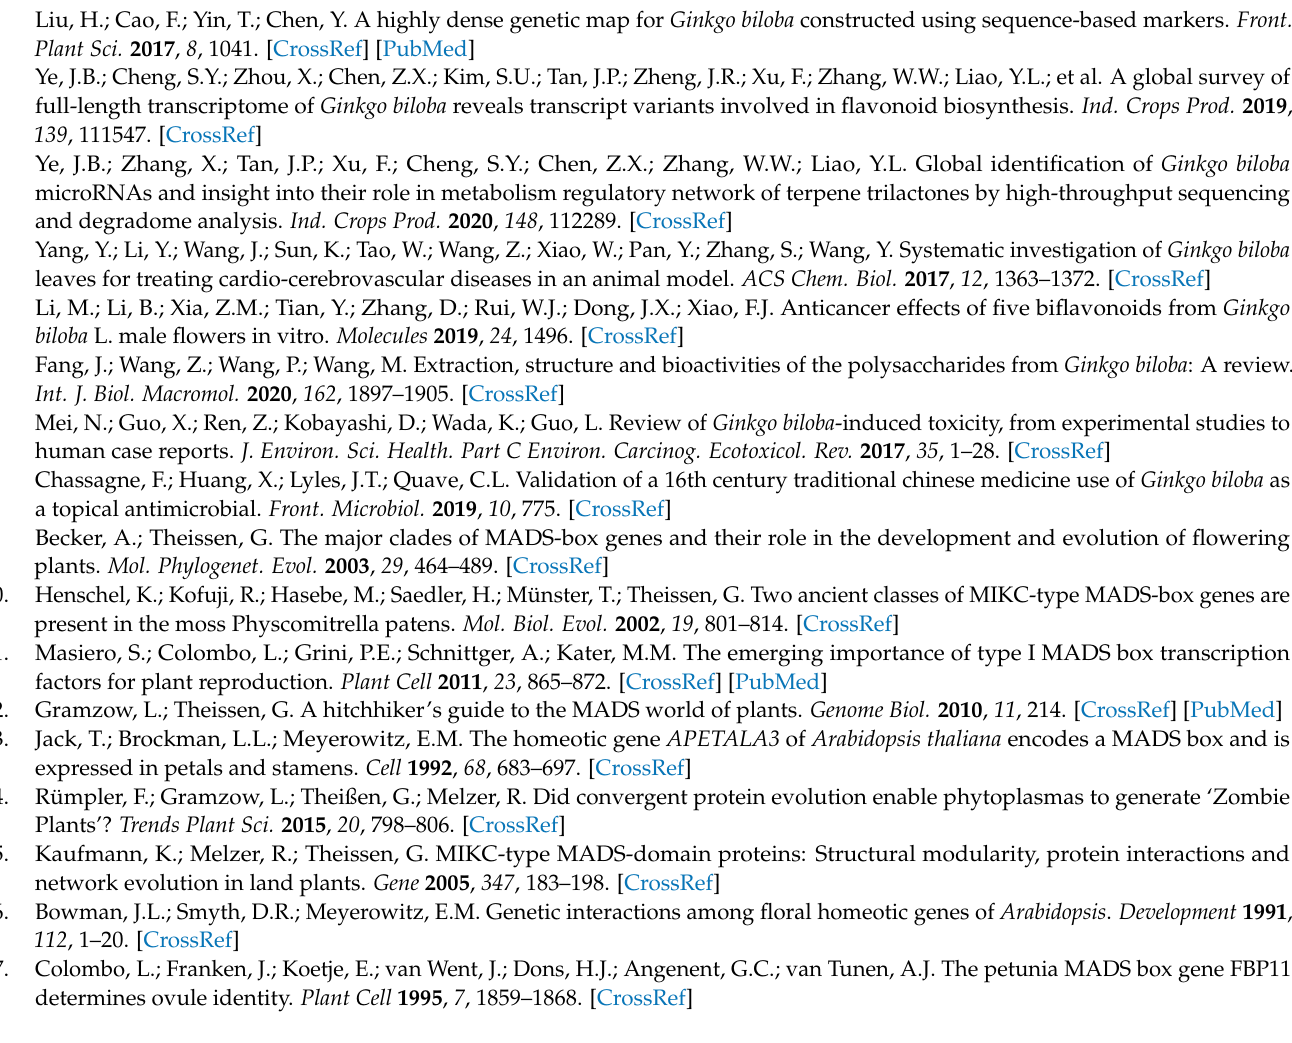
Table S2: Conserved motif sequence of GbMADS gene family in G.biloba ; Table S3: List of relationship between GbMADS gene and